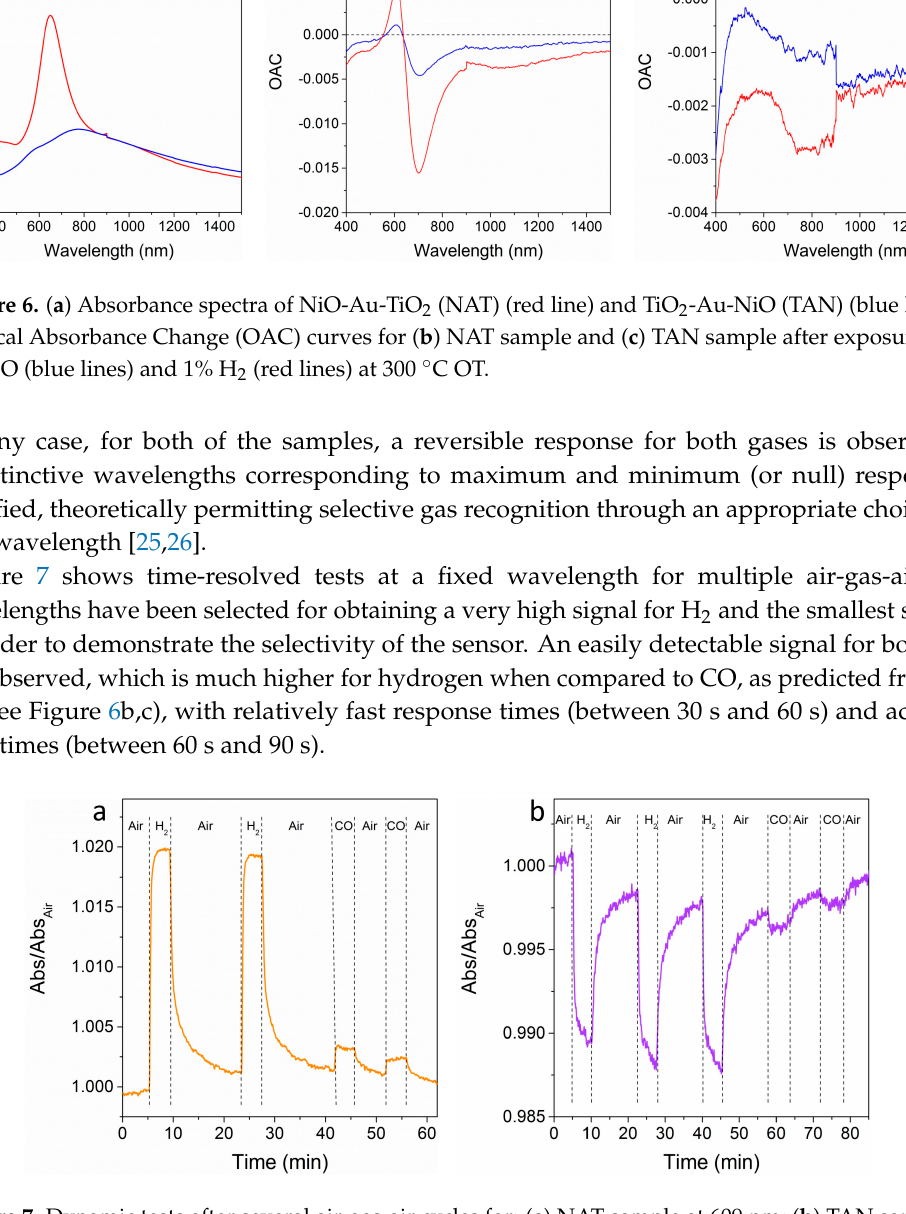
Figure 7. Dynamic tests after several air-gas-air cycles for: ( a ) NAT sample at 609 nm; ( b ) TAN sample at 580 nm.